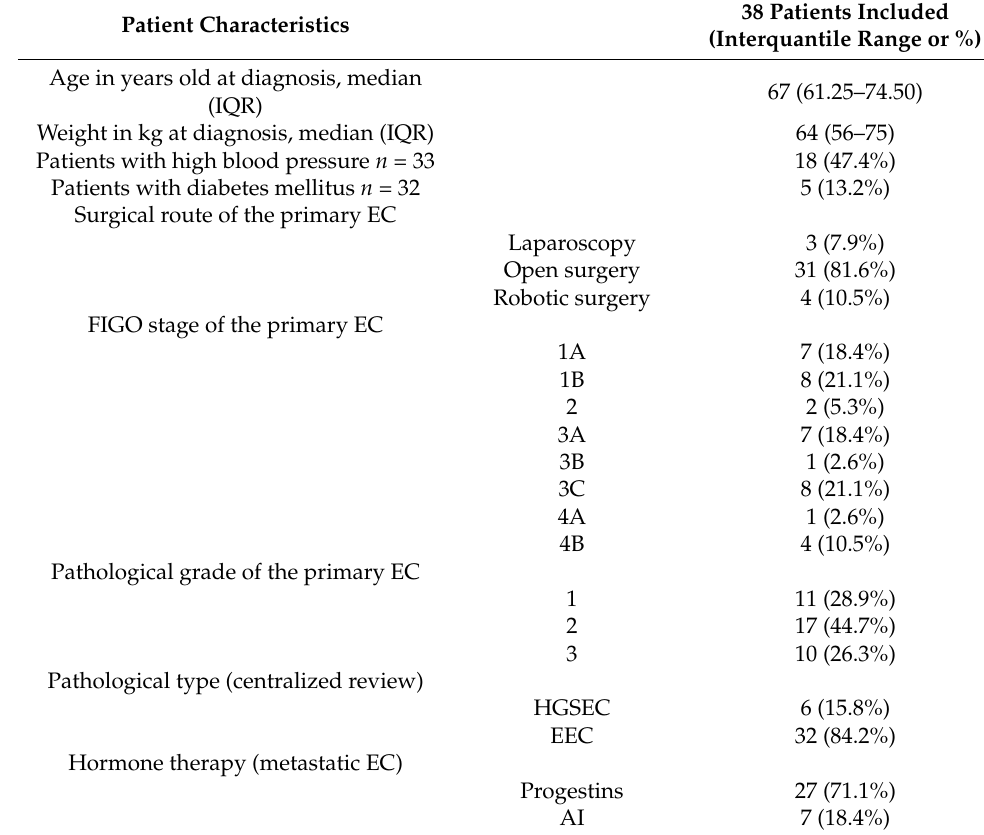
Table 1. Clinicopathological characteristics of patients with endometrial